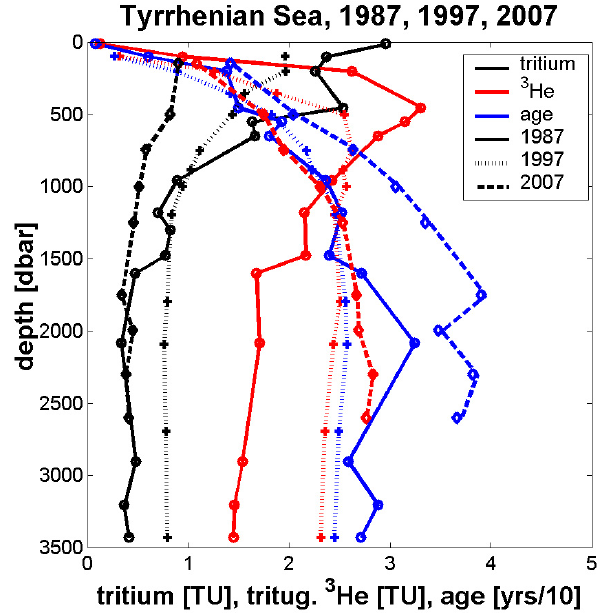
Fig. 5. Tritium, tritiugenic 3 He [TU] and tritium- 3 He age [years/10] in the Tyrrhenian Sea in 1987 (M 5/6, Sta. 786, full lines), 1997 (P OSEIDON 234, Sta. 766, dotted) and 2007 (A EOLIAN 07, V07B- 01, dashed). For station positions see Fig. 1. The scatter in the 1987 tritium profile and in the age profiles reflects the data uncertainties (Sect.